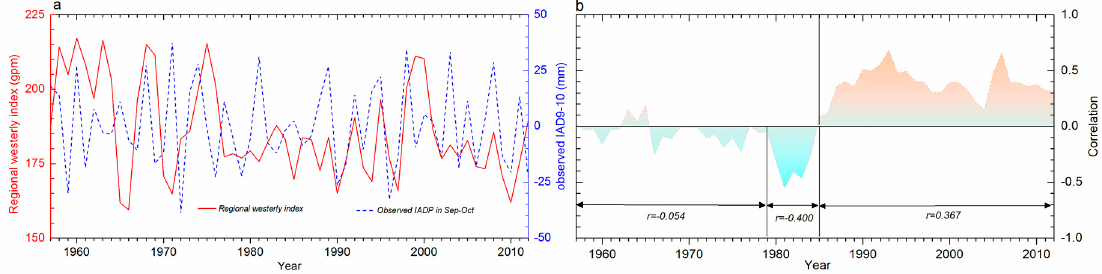
Figure 6. ( a ) Comparison between the September–October averaged regional westerly index and the inter-annual differences in September–October precipitation; and ( b ) the 11-year moving correlation between